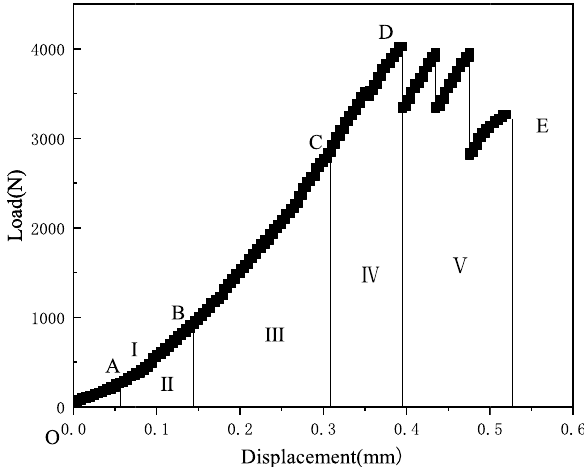
Figure 5: Compressive load – displacement curve of SiC f /SiC composite.